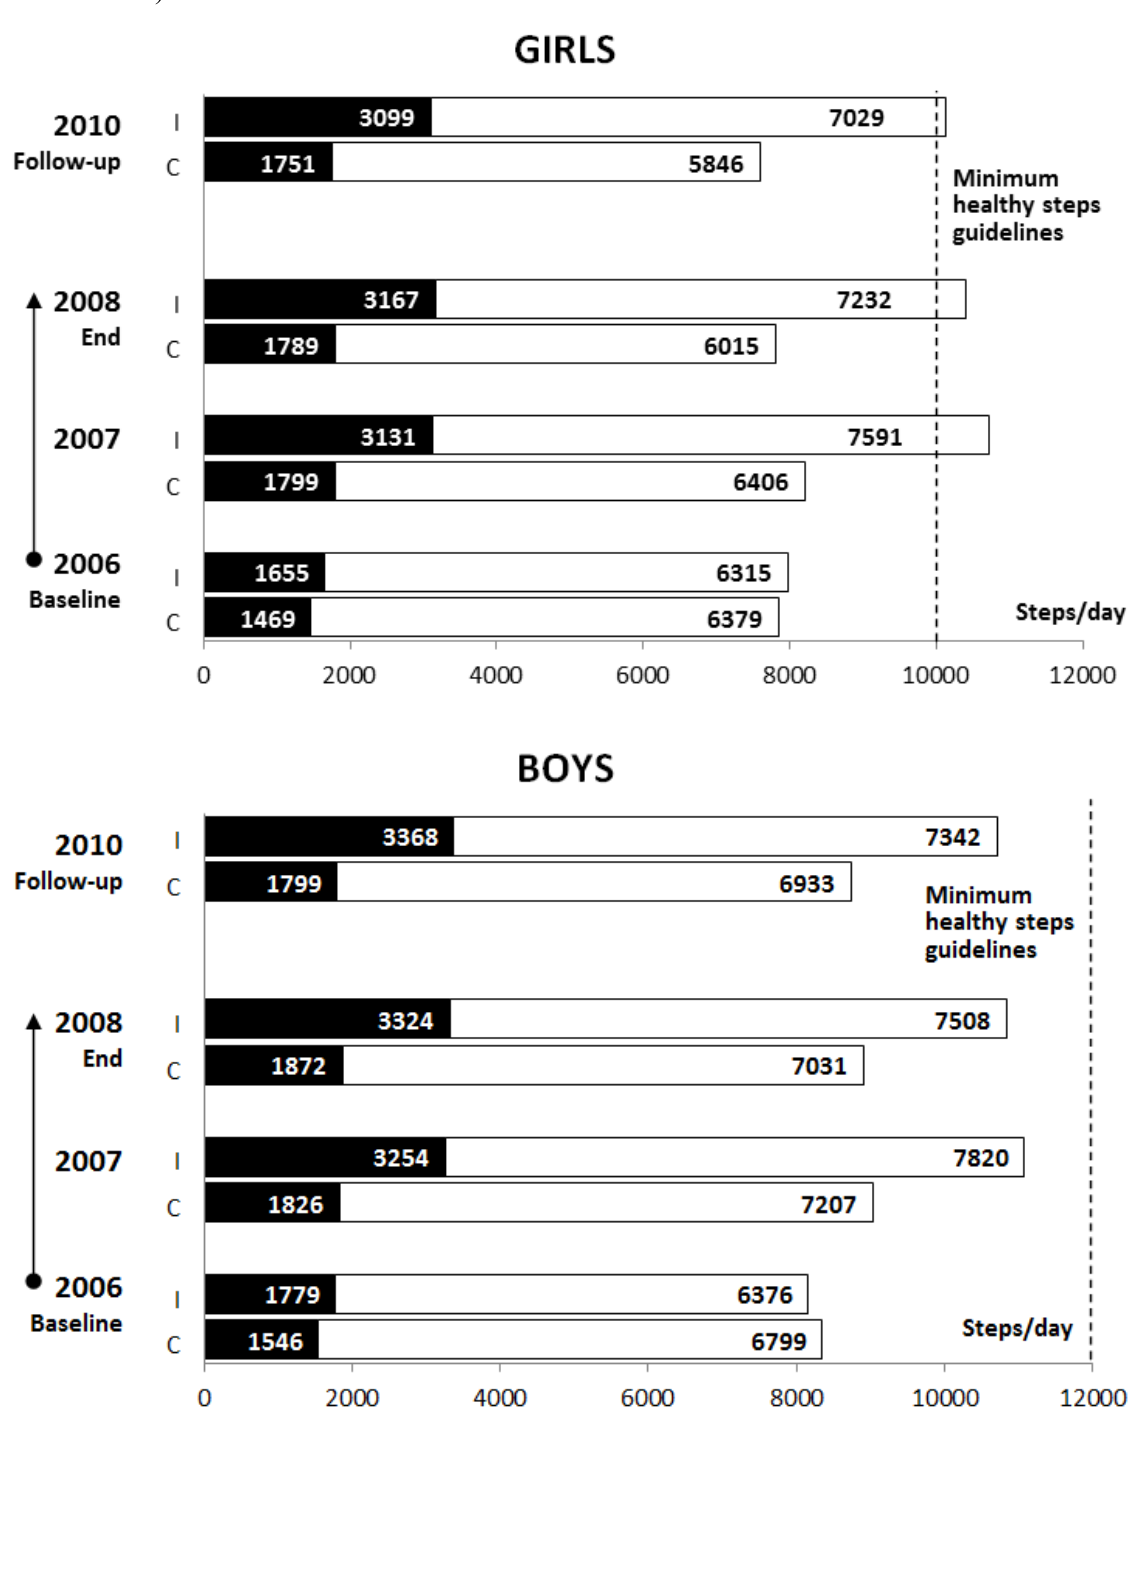
Figure 1. Mean school day step counts of intervention and control children throughout the intervention and follow-up ( ■ —school time; □ —leisure time; I—intervention;